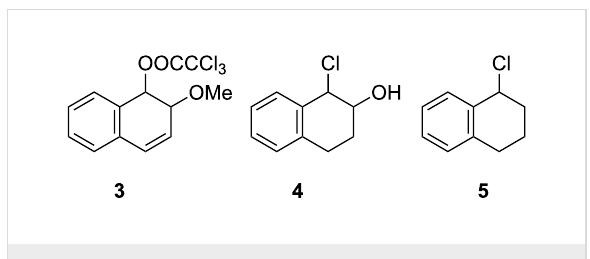
Figure 2: Substrates for solvolysis